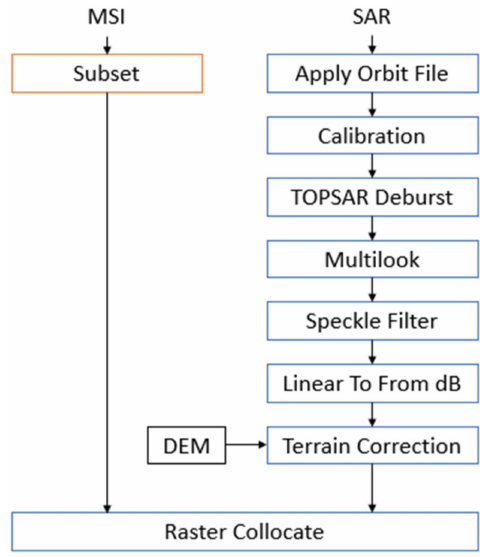
Figure 2. SAR and MSI images